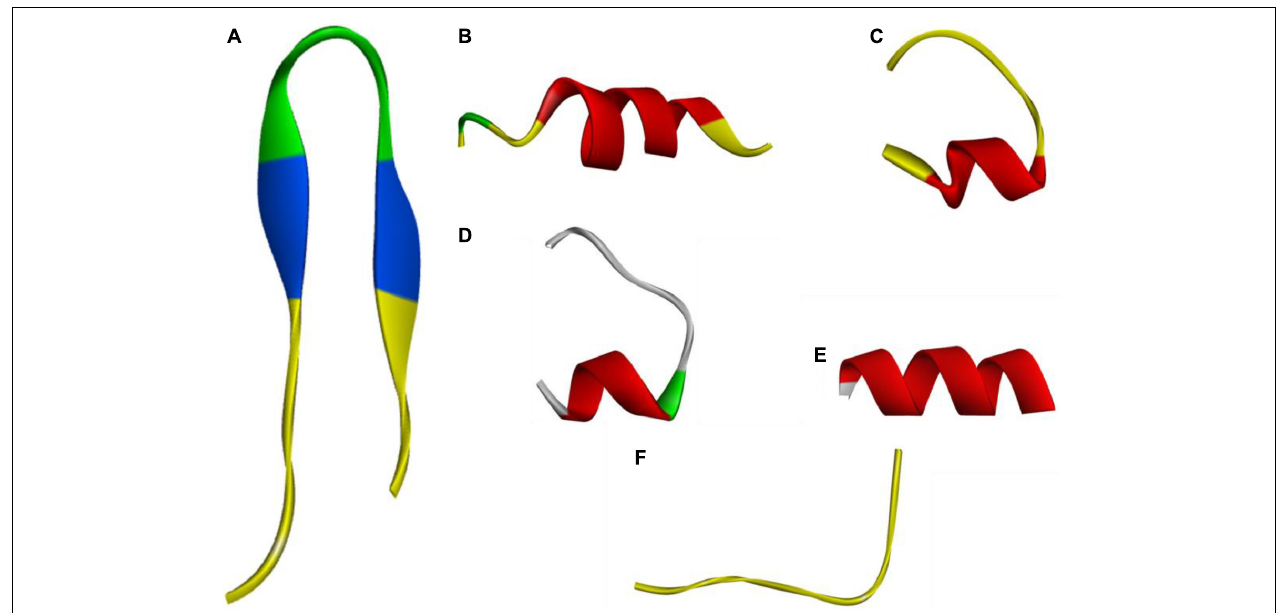
FIGURE 1 | Three-dimensional structure projections of peptides by I-Tasser. (A) , PG-1; (B) , PQ; (C) , PP; (D) , GG; (E) , Qa; (F) , Qna.